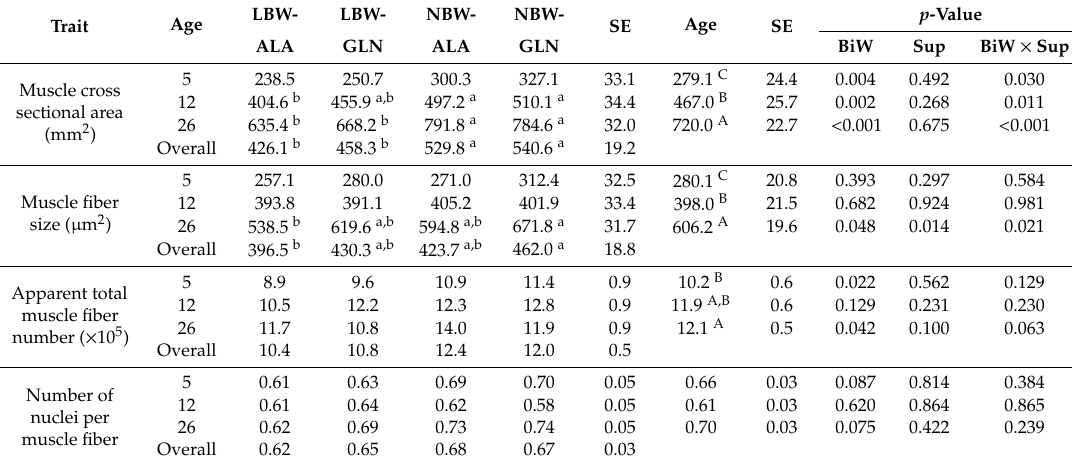
Table 2. Morphological traits in M. longissimus of low (LBW) and normal birth weight (NBW) piglets supplemented with glutamine (GLN) or alanine (ALA) between 1 and 12 dpn ( n = 12 per group and